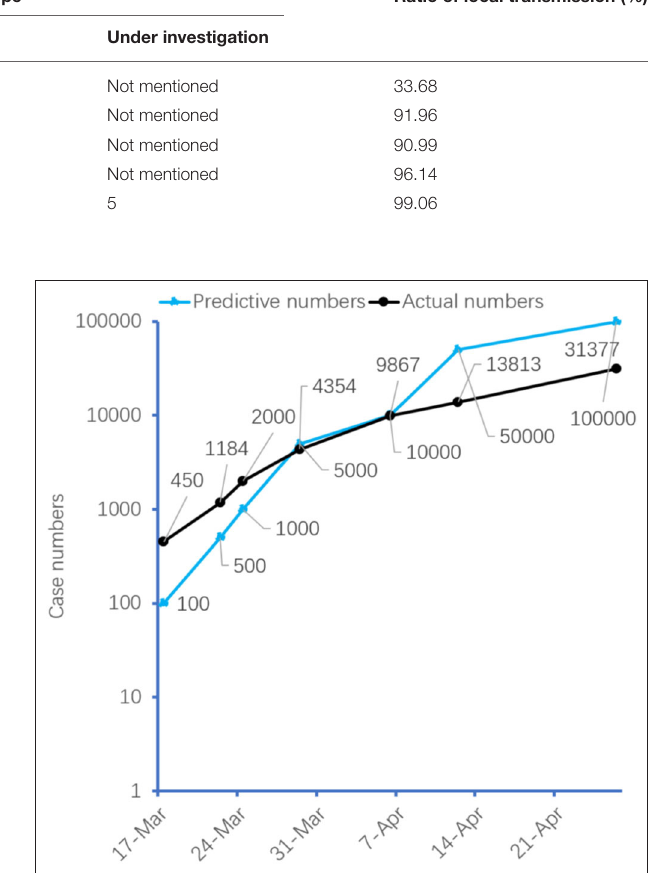
FIGURE 4 | Test positive rate and test intensity in different Africa regions.